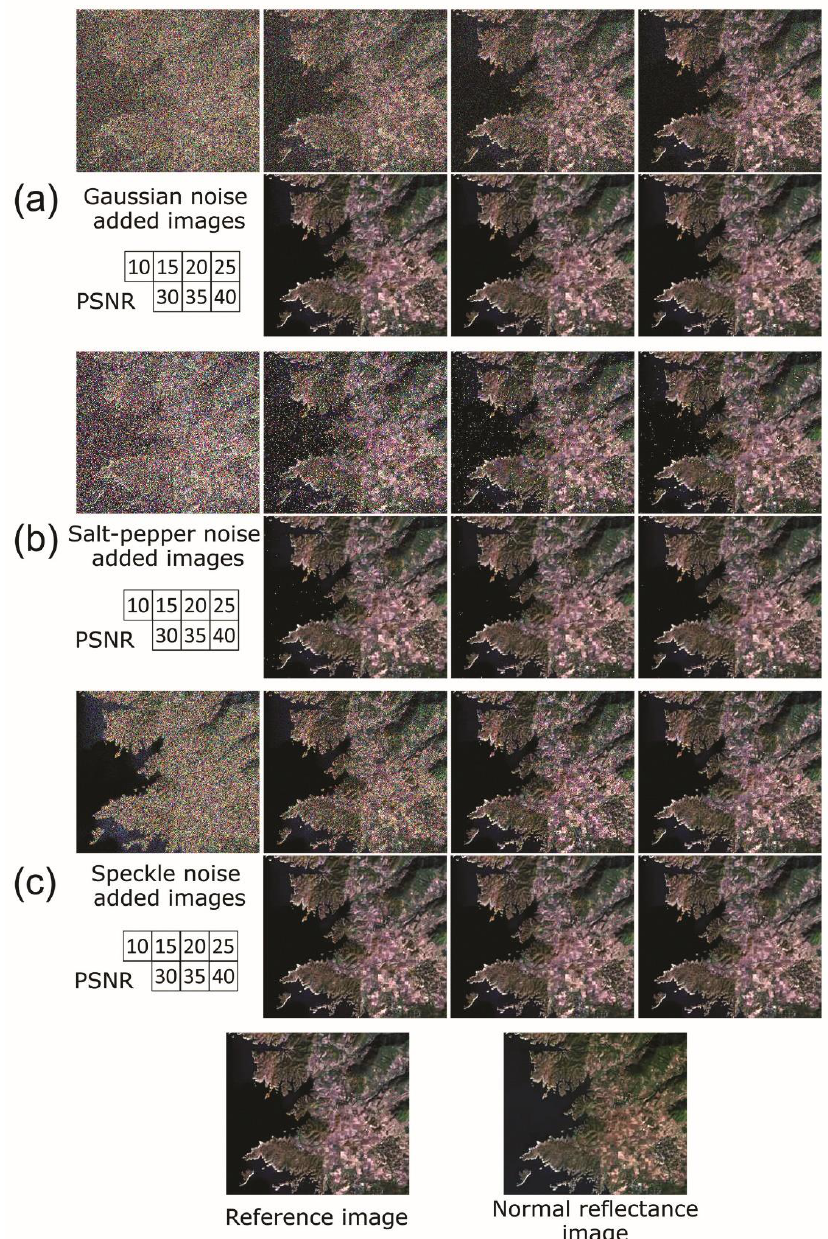
Figure 3. Twenty-three satellite images with added noise in different peak signal-to-noise ratios (PSNRs): ( a ) Gaussian noise, ( b ) salt–pepper noise, and ( c ) speckle noise (true color image; R = band 4, G = band 3, and B = band 2)